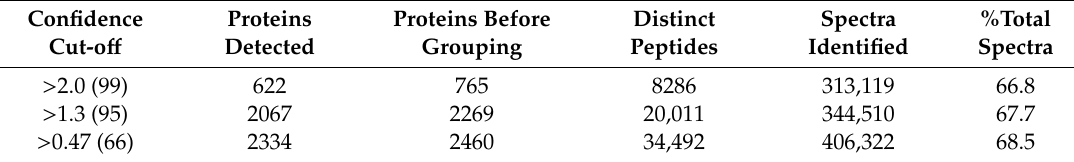
Table 1. The number of proteins and peptides identified after liquid chromatography-tandem mass spectrometry analysis of ADSCs and ADSCs treated with VPA.